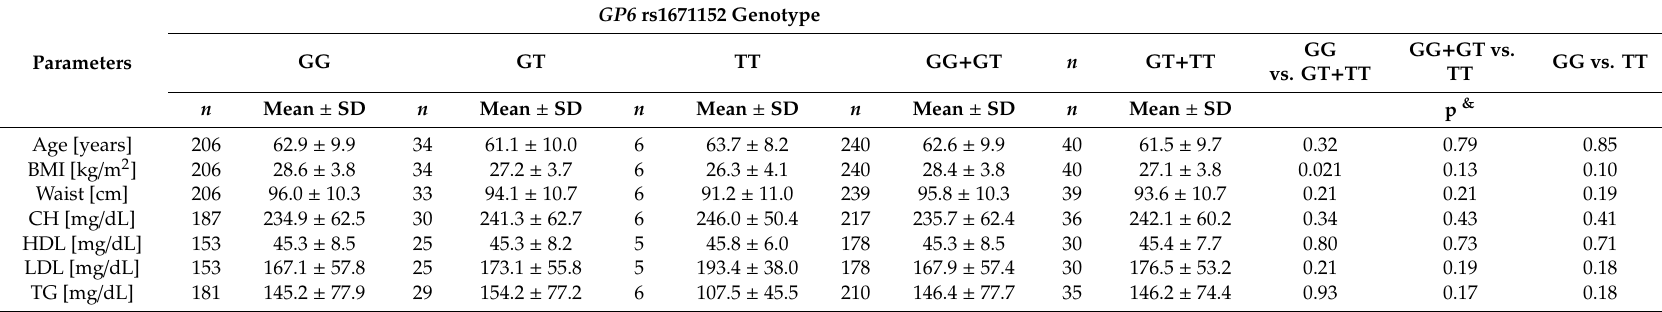
Table 5. Associations between the clinical parameters of patients with unstable angina and the GP6 rs1671152